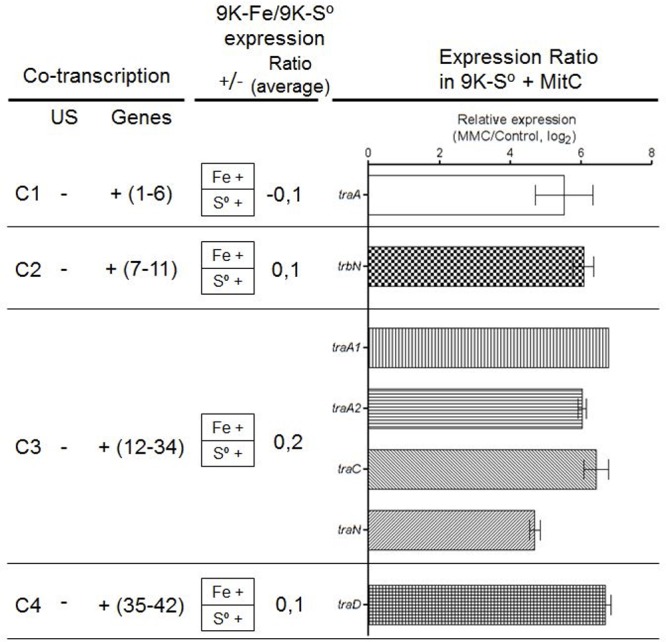
Expression levels of signature conjugative genes. (Left) Co-transcription assay per cluster (C1 to C4). (Middle) Expression ratio in Fe2+ or S0 media (data obtained from Quatrini et al., 2009). (Right) The log2 ratio of mRNA levels as determined by qRT-PCR from Mit C treated cell cultures versus control cultures (traA data obtained from Bustamante et al., 2012). Data were normalized to the expression level of rpoC gene. US, upstream gene. All experiments were performed triplicate.